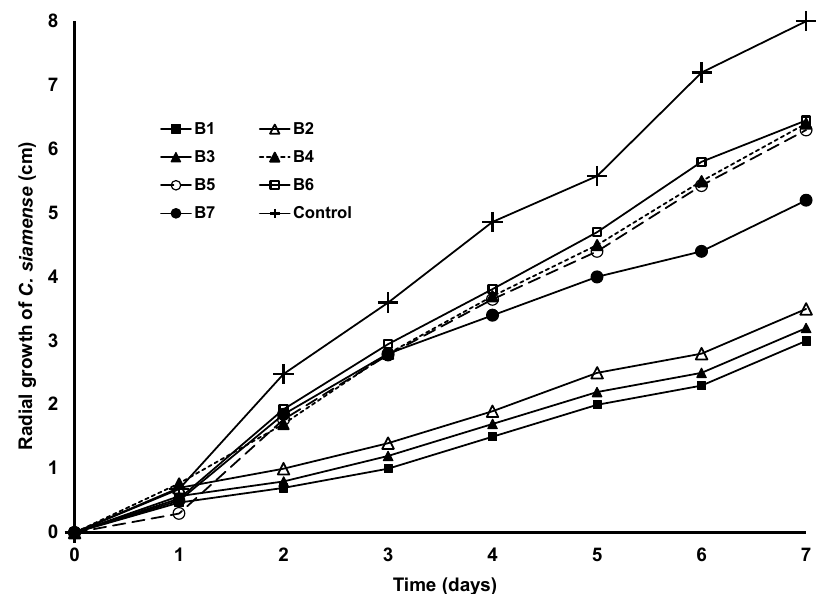
Figure 1. Antifungal effect of seven bacterial strains (B1 to B7) against C. siamense .